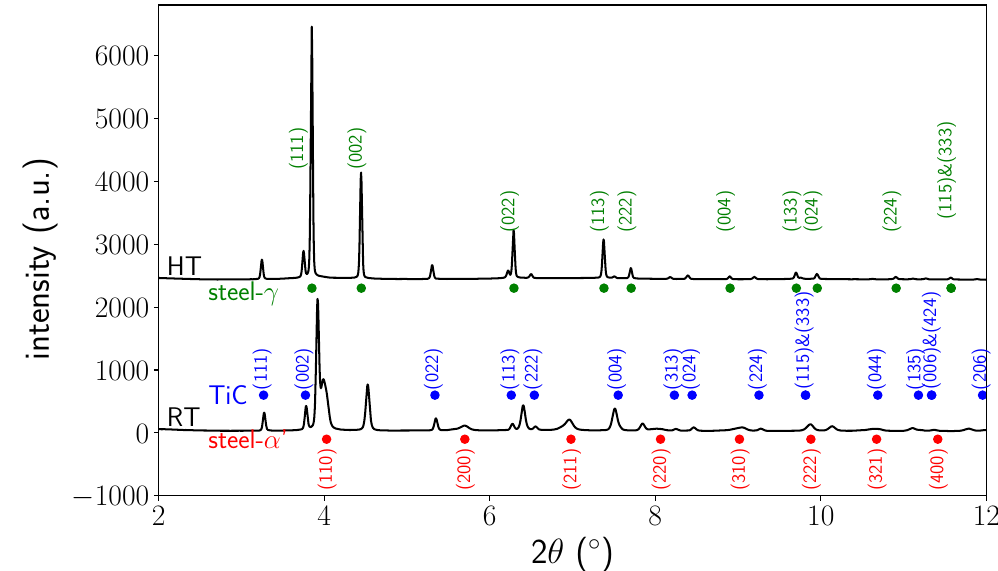
Figure 3. 2D patterns showing austenite and TiC diffraction signals at high temperature (HT) and showing austenite, martensite and TiC diffraction signals at room temperature (RT). Diffractograms from integrated images for the different phases (austenite, martensite ( α ’), TiC).